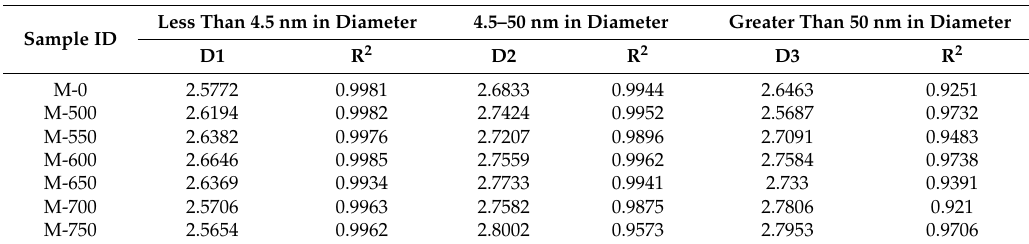
Table 4. Fractal dimensions obtained from N 2 physisorption and mercury intrusion of the shale samples with different